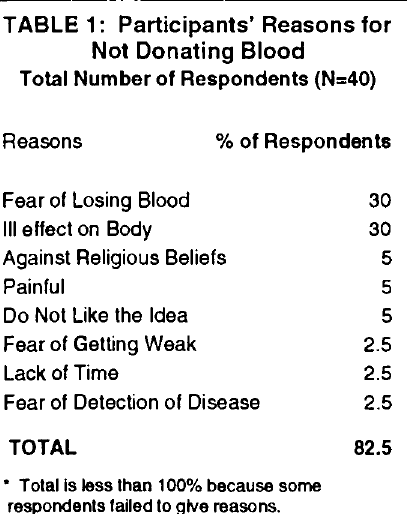
TABLE 1: Participants’ Reasons for Not Donating Blood